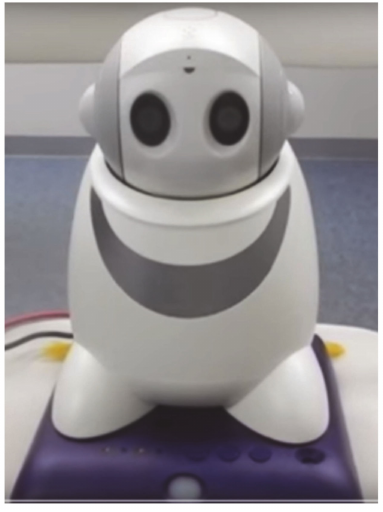
Figure 2. PaPeRo i robot, produced by the NEC